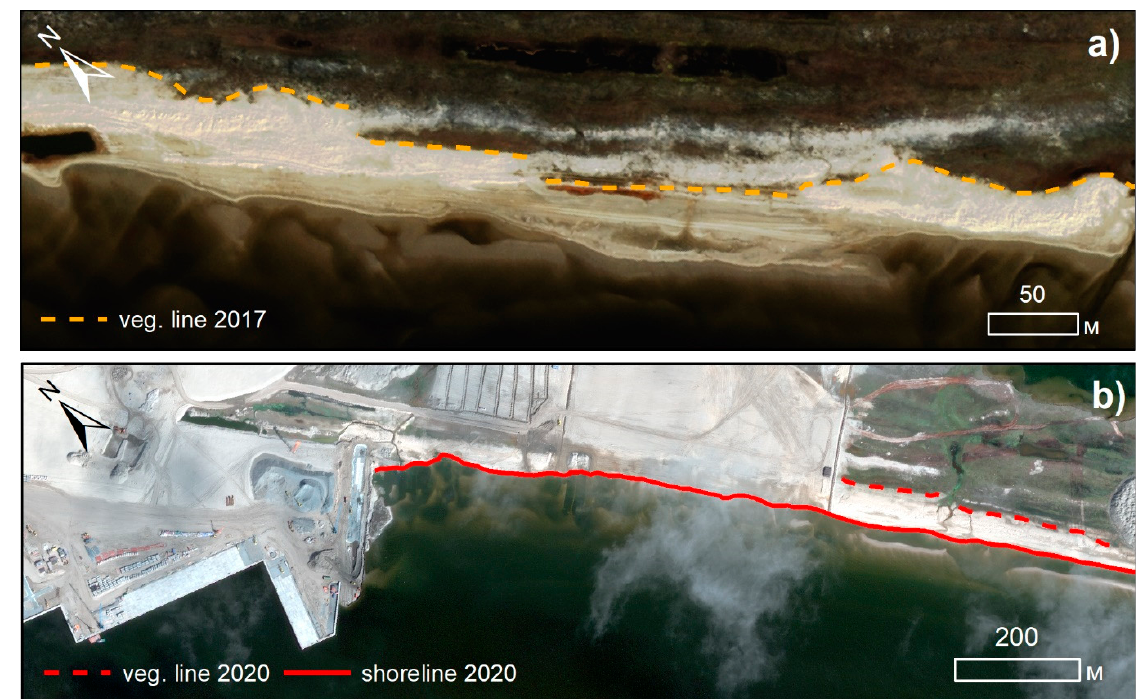
Figure 3. Challenging tracing of coastal lines position: ( a ) due to sandy aeolian cover on the laida surface (WV-2 2012); ( b ) due to construction in the coastal zone (WV-2 2020).